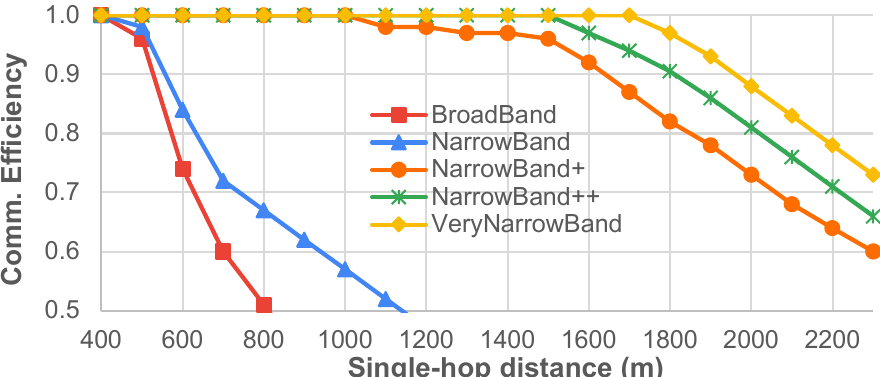
Figure 9. Single-hop communication efficiency at different distances.